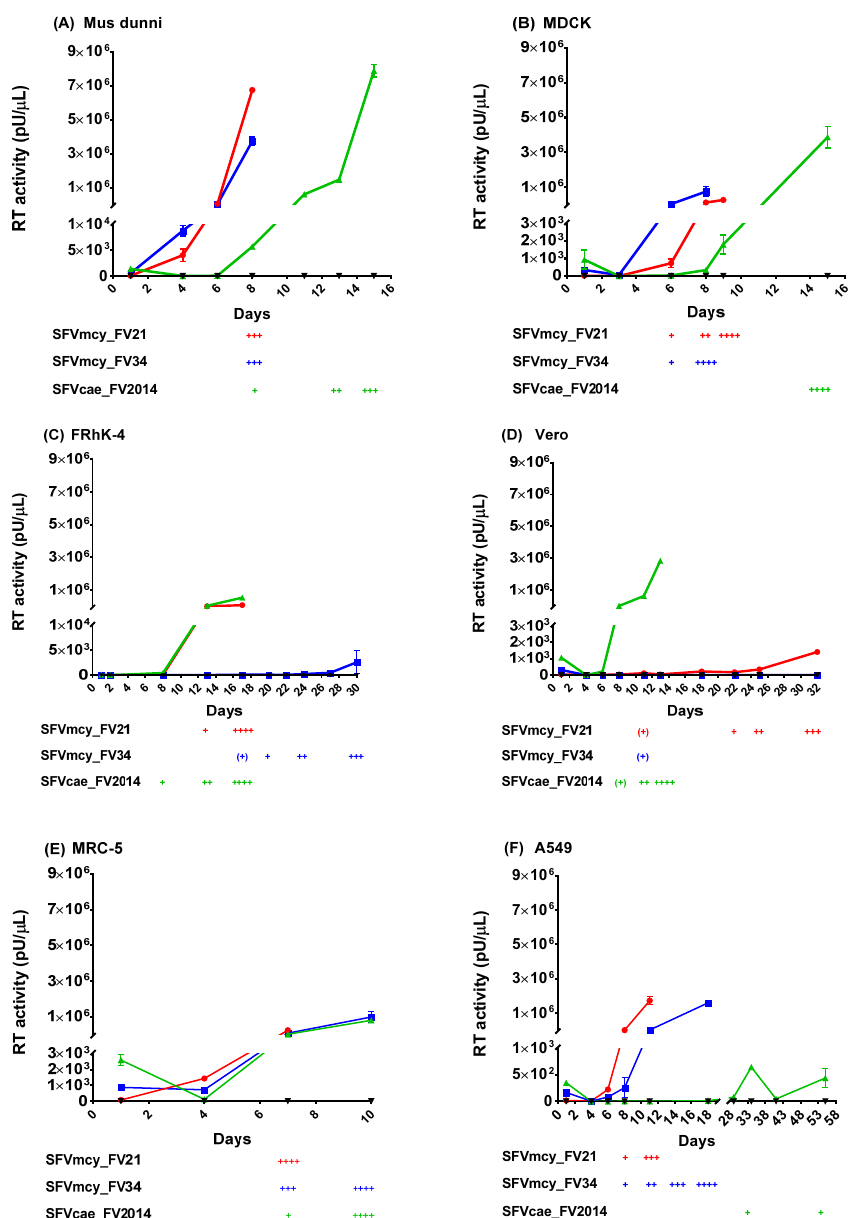
Figure 2. Kinetics of SFV replication. The kinetics of virus replication for SFVcae_FV2014 ( (cid:78) ) were compared with SFVmcy_FV21 ( • ) and SFVmcy_FV34 ( (cid:4) ) in various cell lines from di ff erent species ( A ) M. dunni ; ( B ) MDCK; ( C ) FRhK-4; ( D ) Vero; ( E ) MRC-5; and ( F ) A459 cells. Uninfected cells were the negative control ( (cid:72) ). Data from one of two independent studies are shown. Virus replication was determined based upon virus production in cell-free supernatant using the PERT assay (reported as pU / µ L RT activity) and by visualization of cytopathic e ff ect (CPE) development in the cells (reported as: + for up to 25% cell monolayer a ff ected; ++ , up to 50% monolayer a ff ected; +++ ; up to 75% a ff ected cells; and ++++ , > 75% of cell monolayer a ff ected). SFVmcy_FV21 infection in M. dunni was terminated at 3 + CPE due to insu ffi cient cells for further passage. For comparison, the reverse transcriptase (RT) activity shown in the segmented Y-axis of the graph has the same Y-maximum value, although di ff erent cell lines had varied peak RT. The segmented, linear Y-axis shows the virus input and low-level RT activity on the bottom segment and the peak RT activity on the top segment. Error bars represent the SEM of virus supernatant samples tested in triplicate ( M. dunni , MDCK, and MRC-5) or duplicate (Vero, FRhK-4, and A549) in the PERT assay. All samples from one cell line were tested in the same PERT